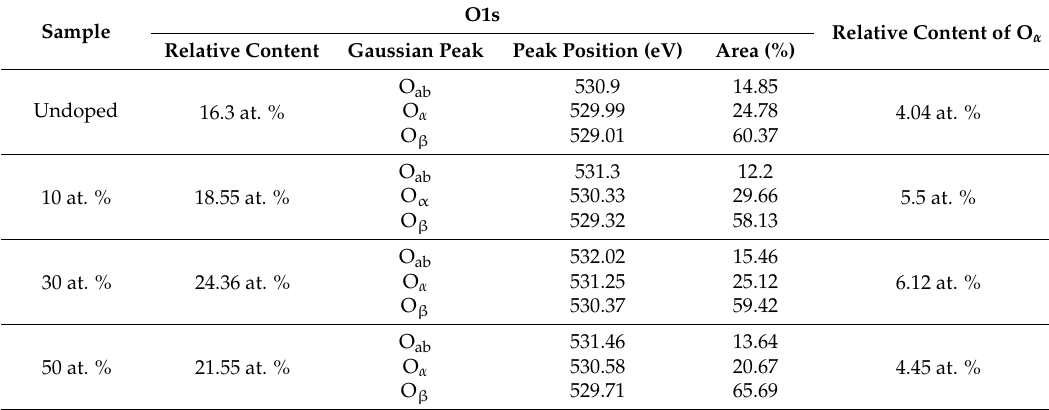
of SnO 2 and FTO